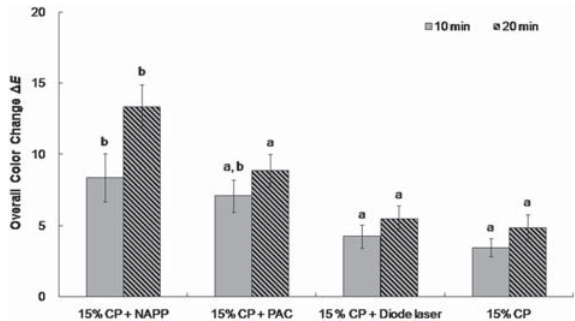
Figure 3- The tooth bleaching effects of three